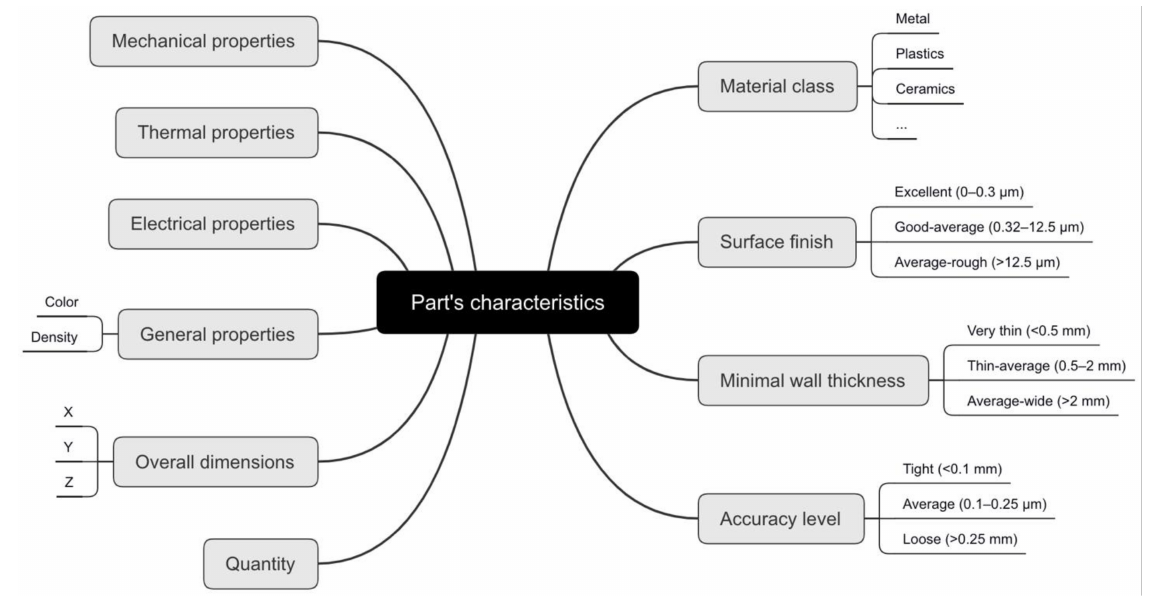
Figure 3. Part characteristics for AM techniques